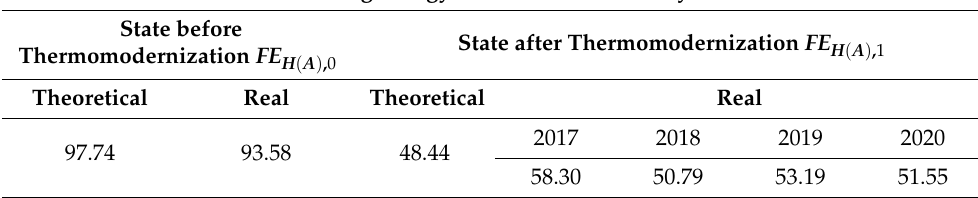
Table 9. The theoretical and real indicator of seasonal final energy demand FE H ( A ) 0,1 before and after thermomodernization in 2017–2020 in the tested building